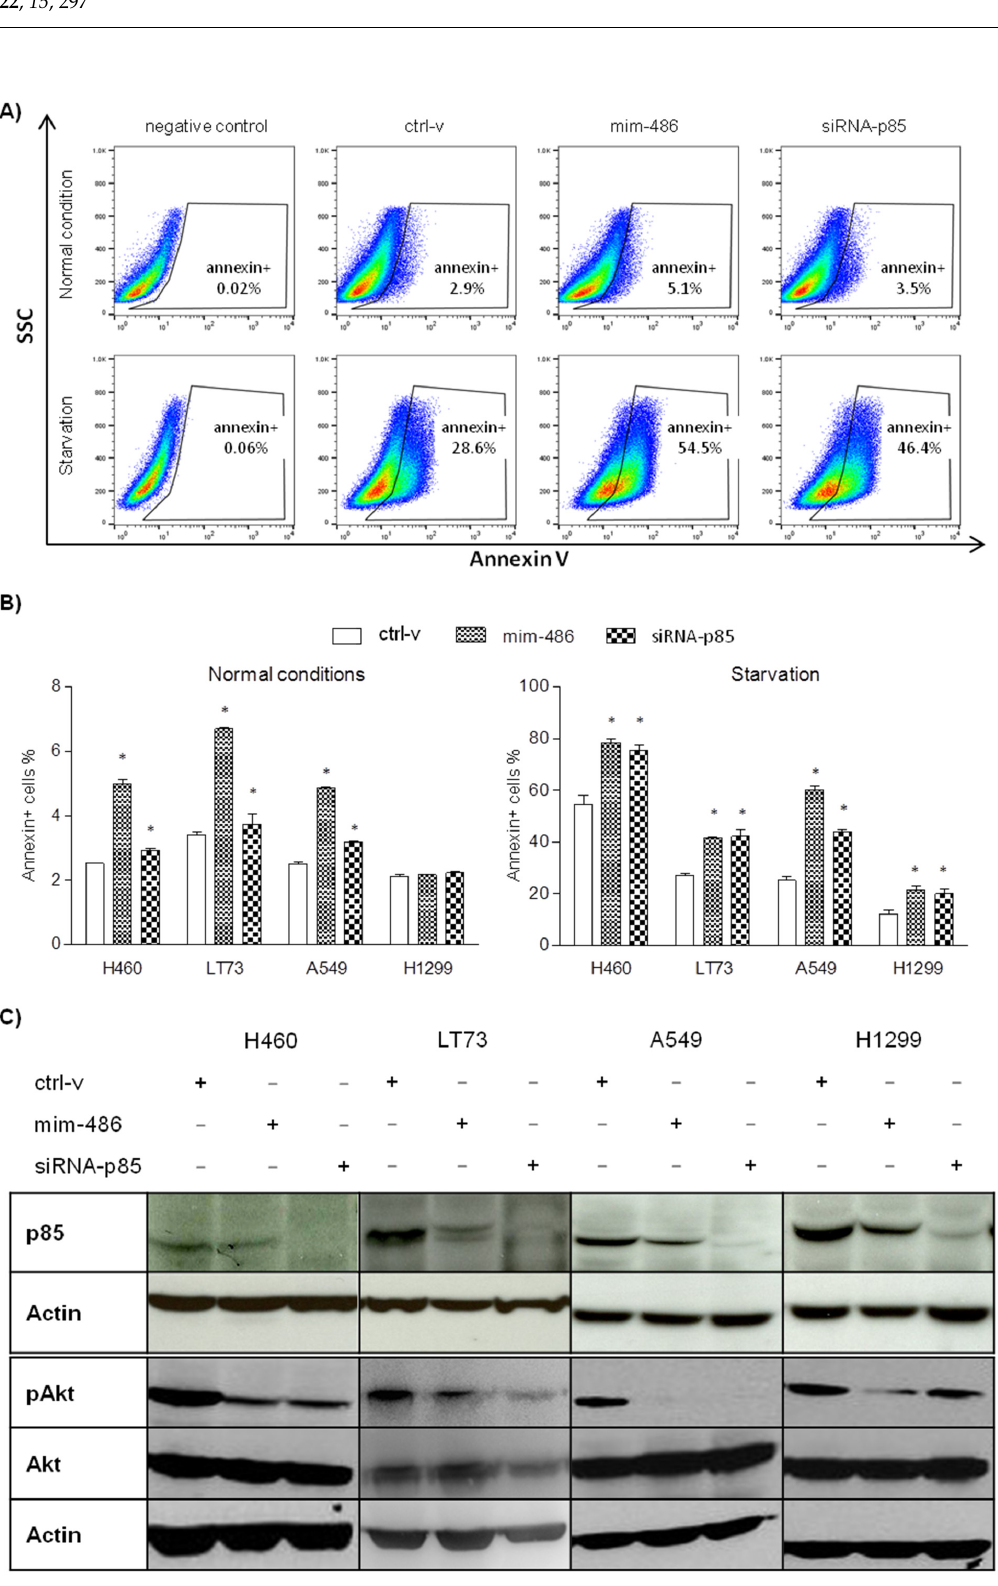
Figure 2. miR-486-5p induced cell survivability of lung cancer cell lines regulating the p85/AKT pathway. ( A ) In A549 and ( B ) other lung cancer cell lines cultured in both normal and starved conditions, the mim-486 and siRNA-p85 transfection induced early apoptosis, evaluated as percentage of Annexin+ cells by flow-cytometry. ( C ) Western blot of H460, LT73, A549, and H1299 cell lines transfected with mim-486, siRNA-p85, and the control vector (ctrl-v) to evaluate the p85/AKT pathway activation. Actin was used as reference to normalize data. *: p < 0.05 vs